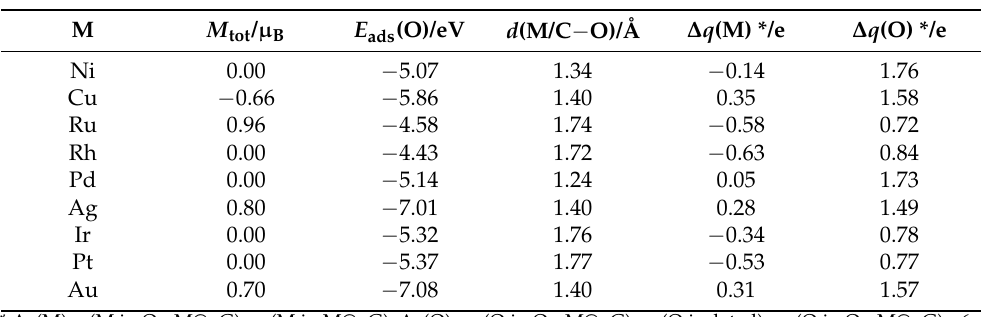
Table 4. O adsorption on the most stable site of M@vG: total magnetizations ( M tot ), O adsorption energies ( E ads (O)), relaxed M − O or C − O distance (depending on O position, d (M/C − O)), change of the Bader charge of M upon adsorption ( ∆ q (M)) and change of the Bader charge of O upon adsorption ( ∆ q (O)).